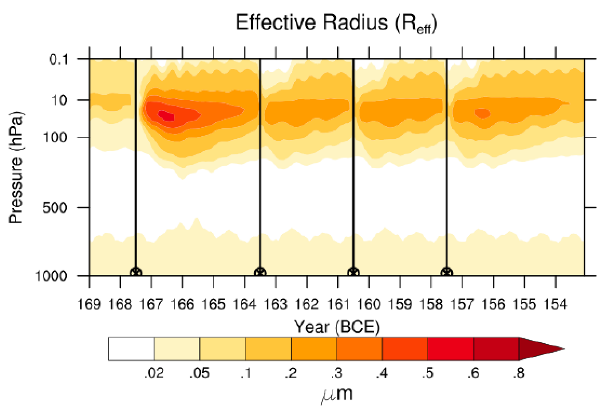
Figure 6. Time series of global ensemble mean vertical profile of sulfate aerosol R eff for the entire simulation period. The vertical black line with a circled cross mark on the horizontal axis shows the eruption